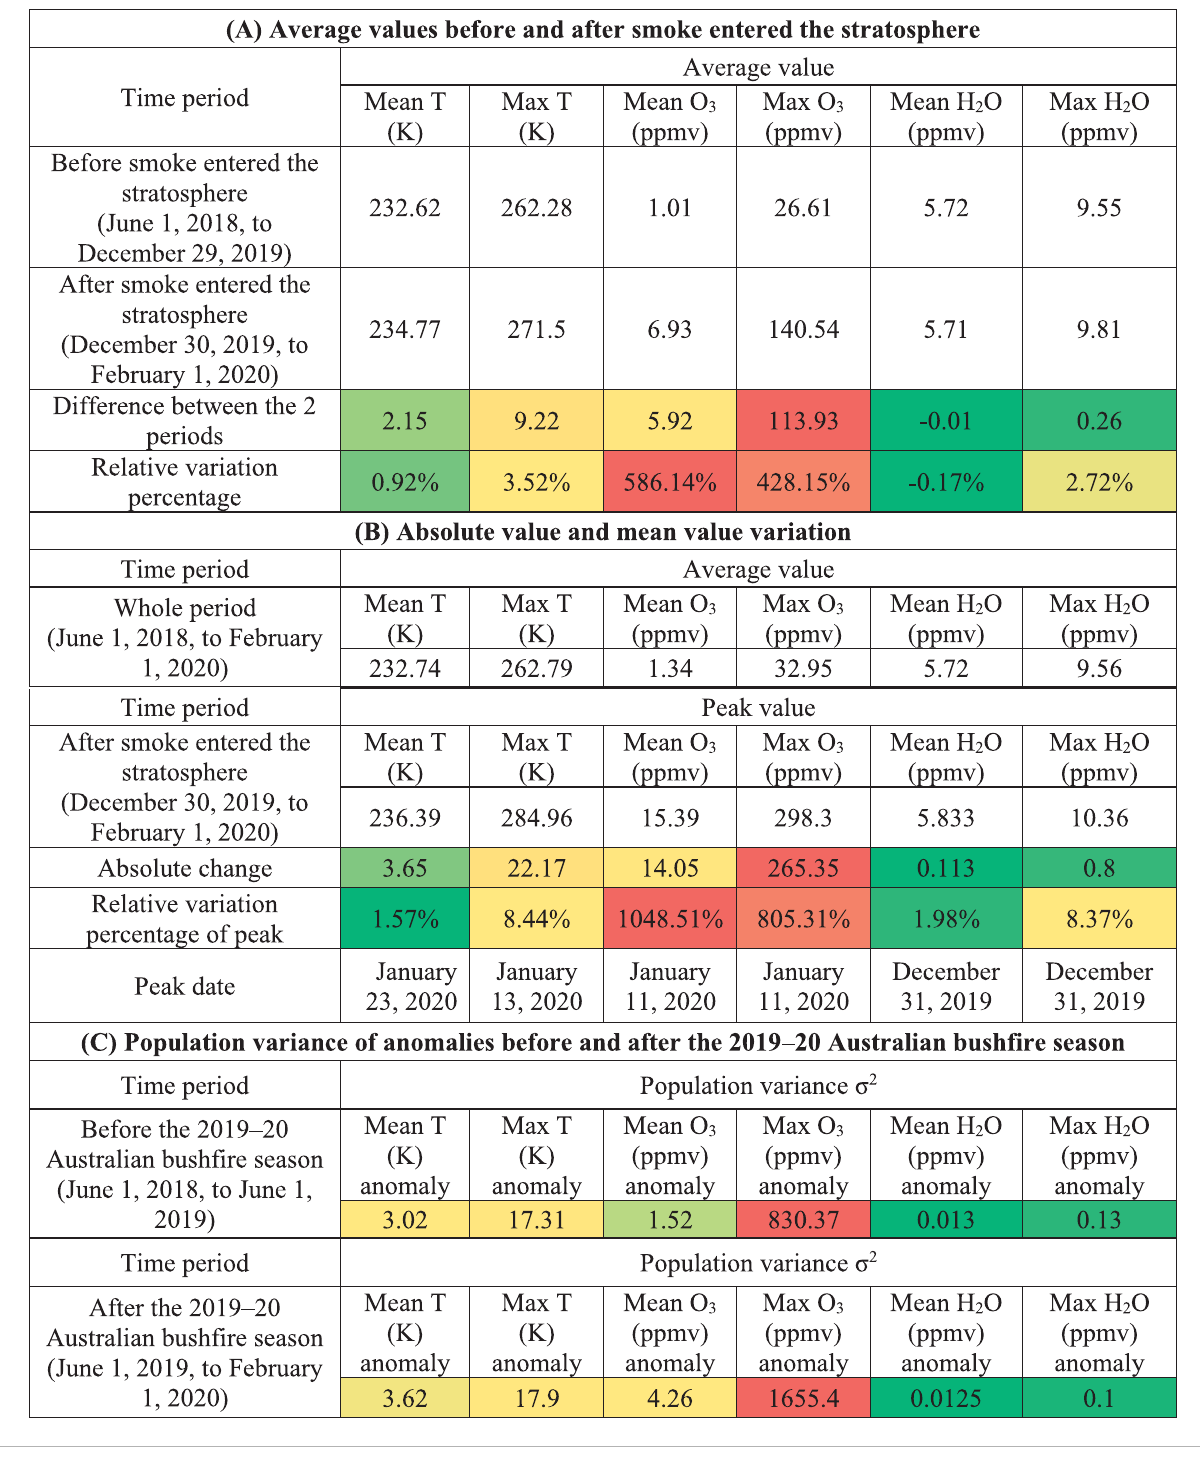
TABLE 1 | Comparison of stratospheric components before and after (A,B) smoke entered the stratosphere, (C) the 2019-20 Australian bush fi re season begins.